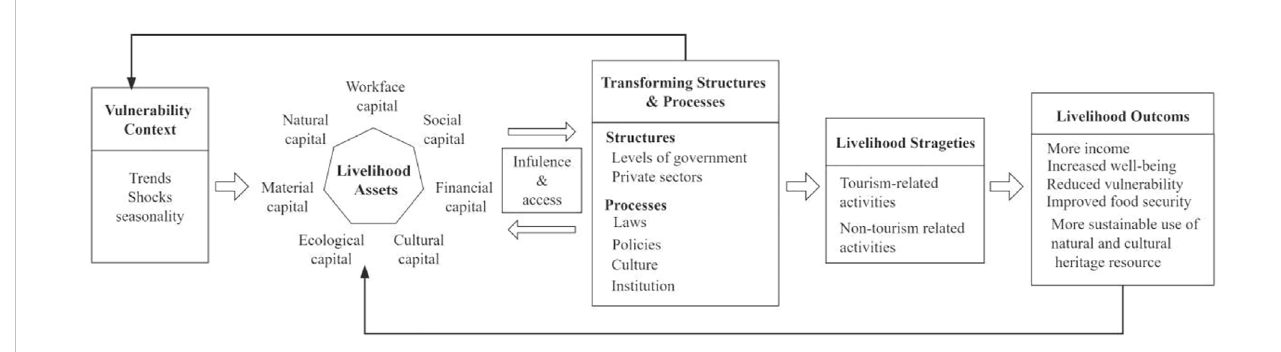
Sustainable livelihood framework for ecocultural tourism [adapted from the DFID.